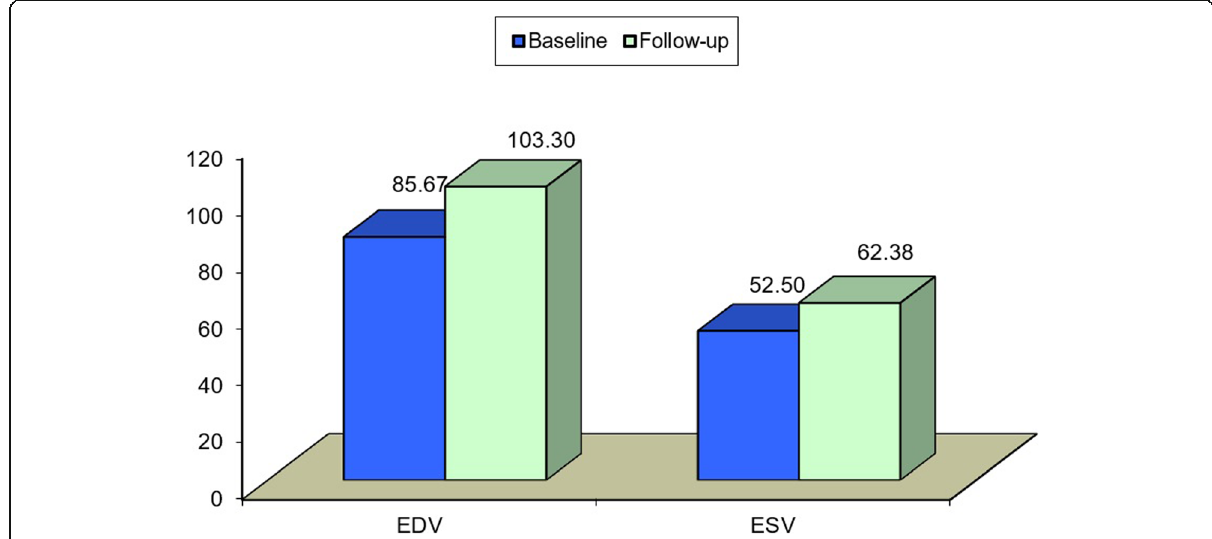
Fig. 2 A chart showing LV EDVI and ESVI measured at 1st (baseline) and 2nd (follow-up)